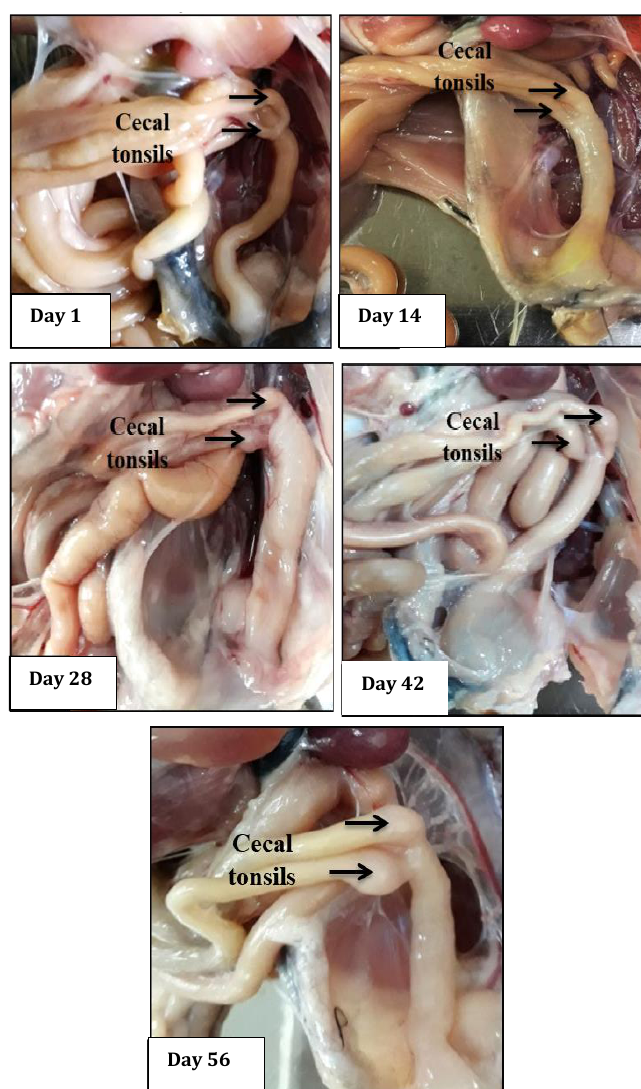
Figure 1 . Gross photographs of the cecal tonsil of Sonali chicken. Cecal tonsil located bilaterally at proximal part of paired ceca. This lymphoid organ develops according to age and become more tubular structure